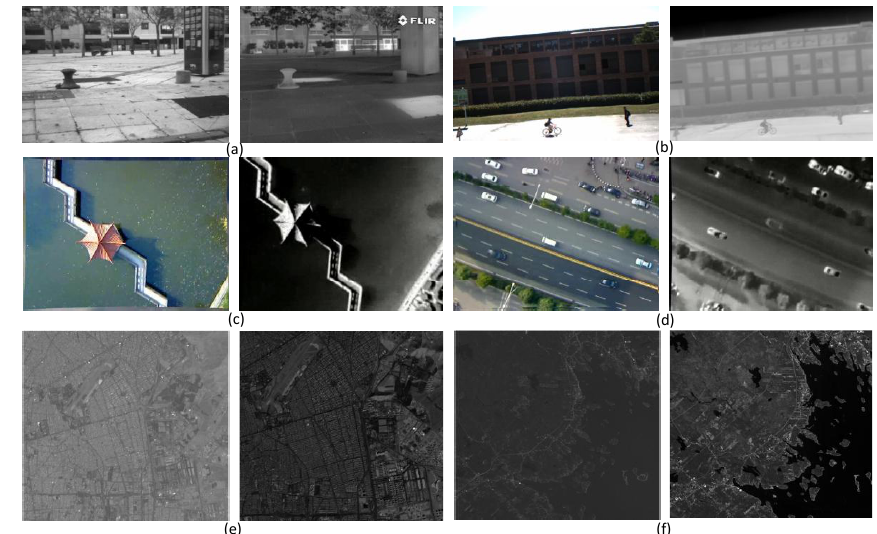
Figure 8. Samples of multi-sensor image pairs in the three datasets. ( a , b ) are two image pairs from the CVC dataset using optical camera and infrared camera devices [48,49]; ( c , d ) are two image pairs from the UAV dataset using optical and thermal camera devices by ourselves; and ( e , f ) are two multi-sensor and multi-temporal image pairs from the SAT dataset using different satellites. Referring to [7], the details of the (left vs. right) images in ( e ) include: satellite type (IRS-1C vs. ASTER), spectral mode (Pan vs. Band3), and acquisition date (1998 vs. 2006); the details of the (left vs. right) images in ( f ) include: satellite type (SPLOT5 vs. LANDSAT ETM+), spectral mode (Band2 vs. Band3), and acquisition date (2006 vs. 1999).